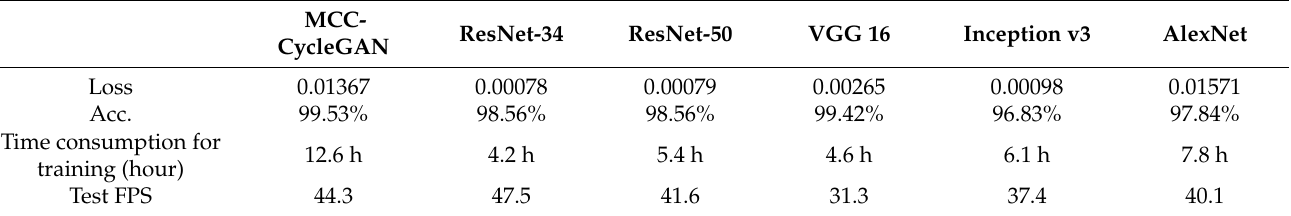
Figure 8. The samples from real belt surface images and transferred images from the steel surface dataset. Images on the left side are sampled from real belt dataset, and the images on the right side are transferred ones. Table 3. The comparison of each algorithms.